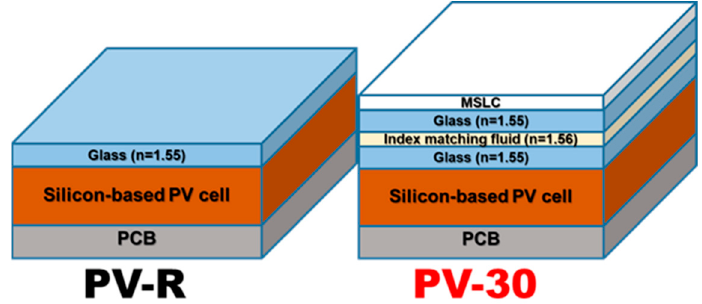
Figure 6. Schematic illustration of the two modules evaluated in this work. Table 1. Measured J-V characteristics of PV-R and PV-30. Data represent the average of 15 measurements. ↑ The arrow represents the percentage increase of PCE compared to the PCE of the PV-R.